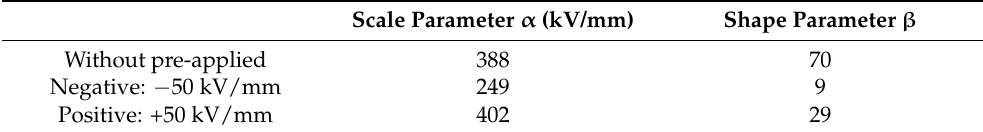
Figure 10. Weibull distribution of breakdown strength of PP at different temperatures. Table 2. Parameters for breakdown strength. Scale Parameter α (kV/mm)